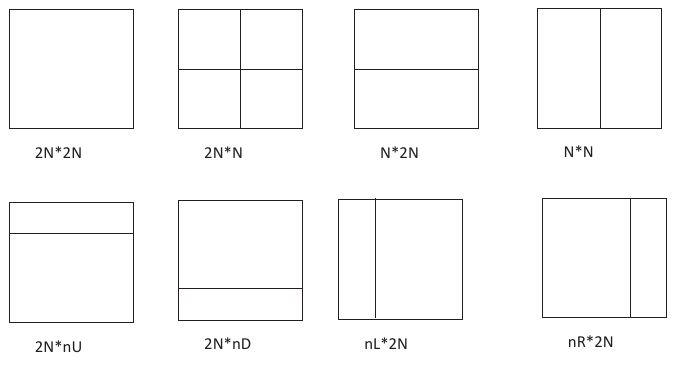
Figure 3. PU modes in H.265/HEVC inter-prediction.